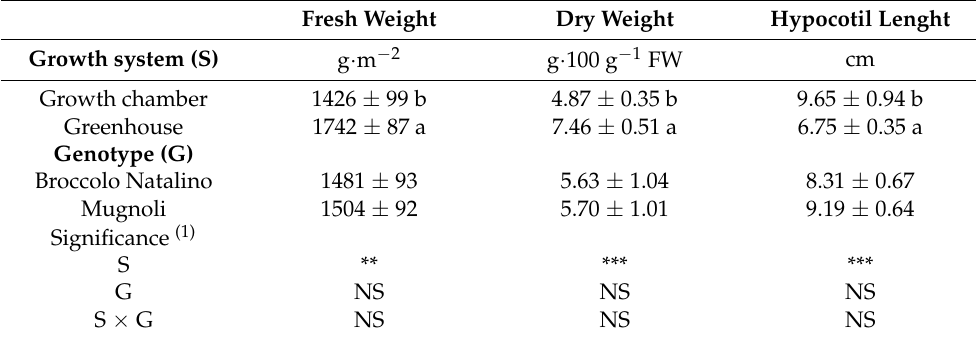
Table 4. Fresh weight, dry weight, and hypocotyl length of two Brassica microgreens (Broccolo Natalino and Mugnoli) cultivated in a growth chamber and greenhouse with sunlight. Means followed by different letters within a column indicate significant differences according to Student– Newman–Keuls (SNK) test at p =